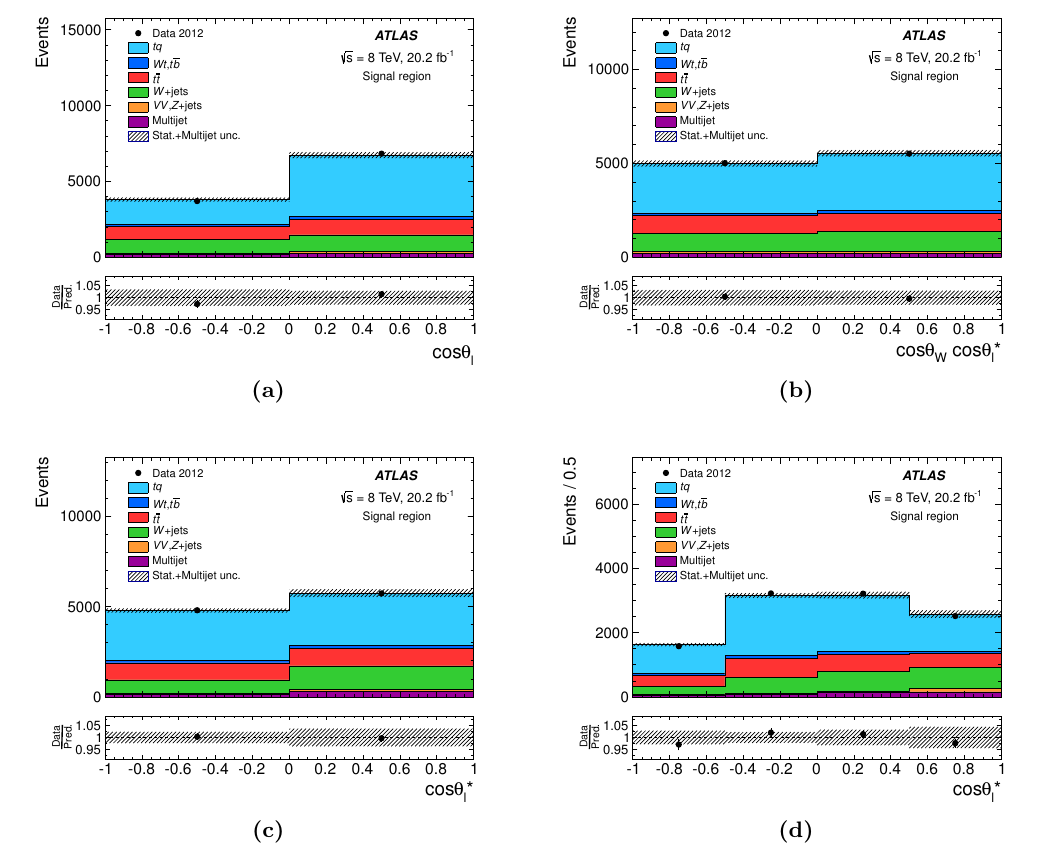
Figure 6. Distributions in the signal region of the angular observables used to measure the various asymmetries: (a) cos (cid:18) ‘ for A ‘ , (b) cos (cid:18) W cos (cid:18) (cid:3) for A tW , (c) cos (cid:18) (cid:3) with two bins for A FB , and (d) FB FB ‘ ‘ cos (cid:18) (cid:3) with four bins for A EC . The observed distributions are compared to the predicted signal and ‘ background distributions, normalised to the results of the maximum-likelihood (cid:12)t. The template t -channel distributions are taken from the baseline Powheg-Box sample. The labels tq and t (cid:22) b refer to the t -channel and s -channel single-top-quark processes, respectively, and V V to diboson production. The uncertainty bands include the statistical post-(cid:12)t uncertainty, the uncertainty due to the limited size of the simulation samples and the uncertainty in the normalisation of the multijet background, added in quadrature. The lower panels show the ratio of data to